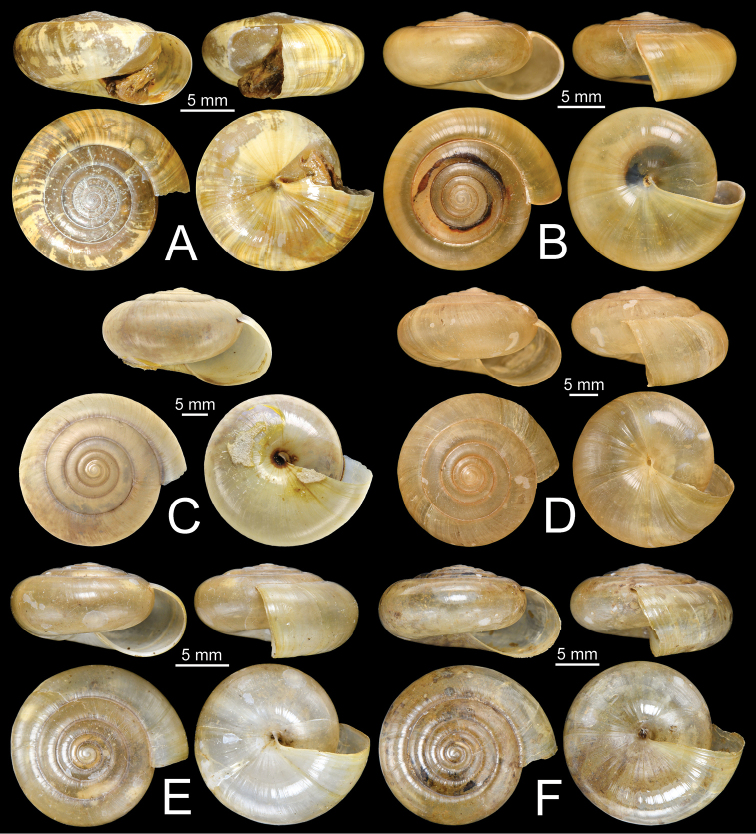
Shells of group I: Sarika
resplendens group. A, BSarika
resplendensA specimen NHMUK 1898.5.18.157 and B specimen CUMZ 7815 C, DS.
dohrnianaC syntype NHMUK 20160046 and D specimen CUMZ 7611. E, FS.
obesiorE specimen CUMZ 7675 and F specimen CUMZ 7673.